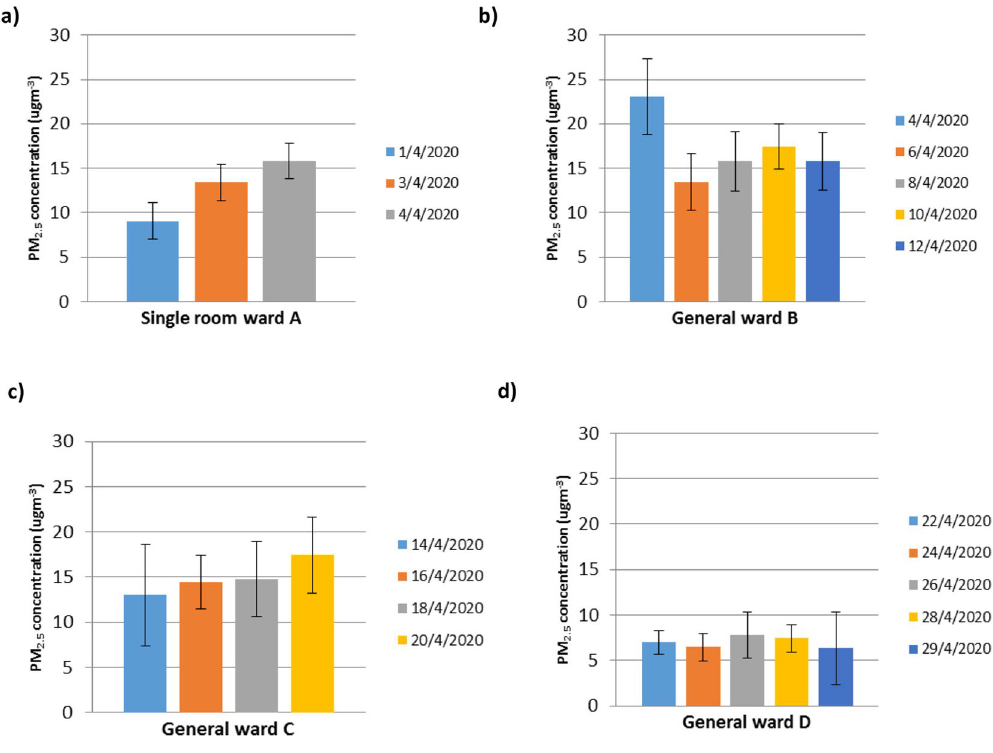
Figure 2. 48 h average concentration PM 2.5 at a single room ward A b general ward B, c general ward C and d general ward D.